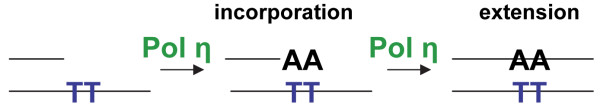
One- polymerase error-free bypass of a UV-induced TT-CPD carried out by TLS Pol η (adapted from [247]). See text for details.